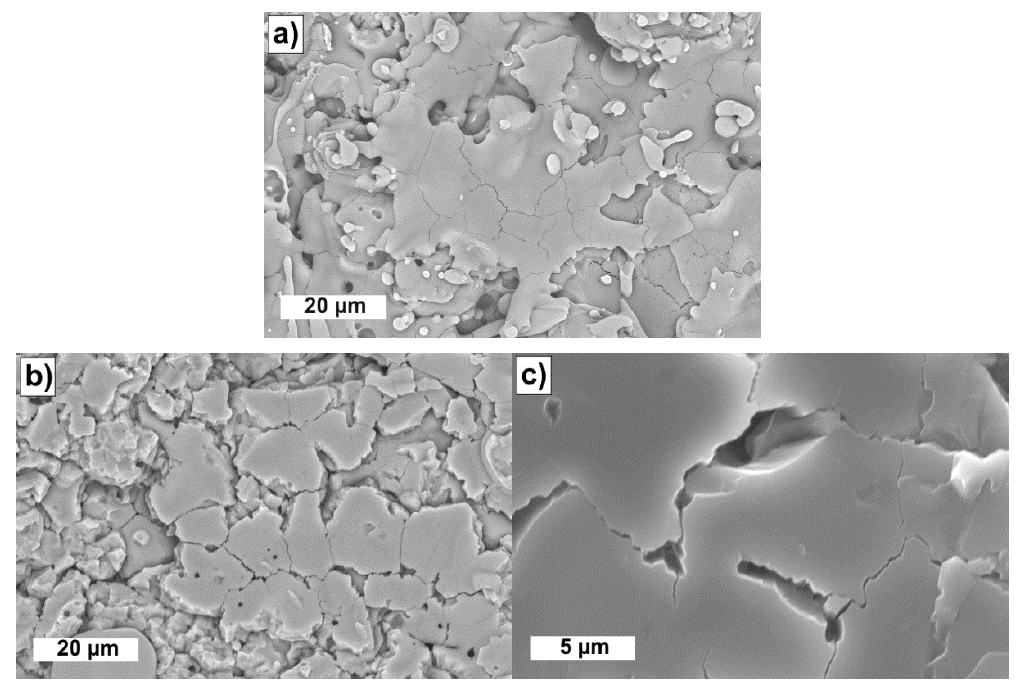
O -13TiO particle removed 2 3 2